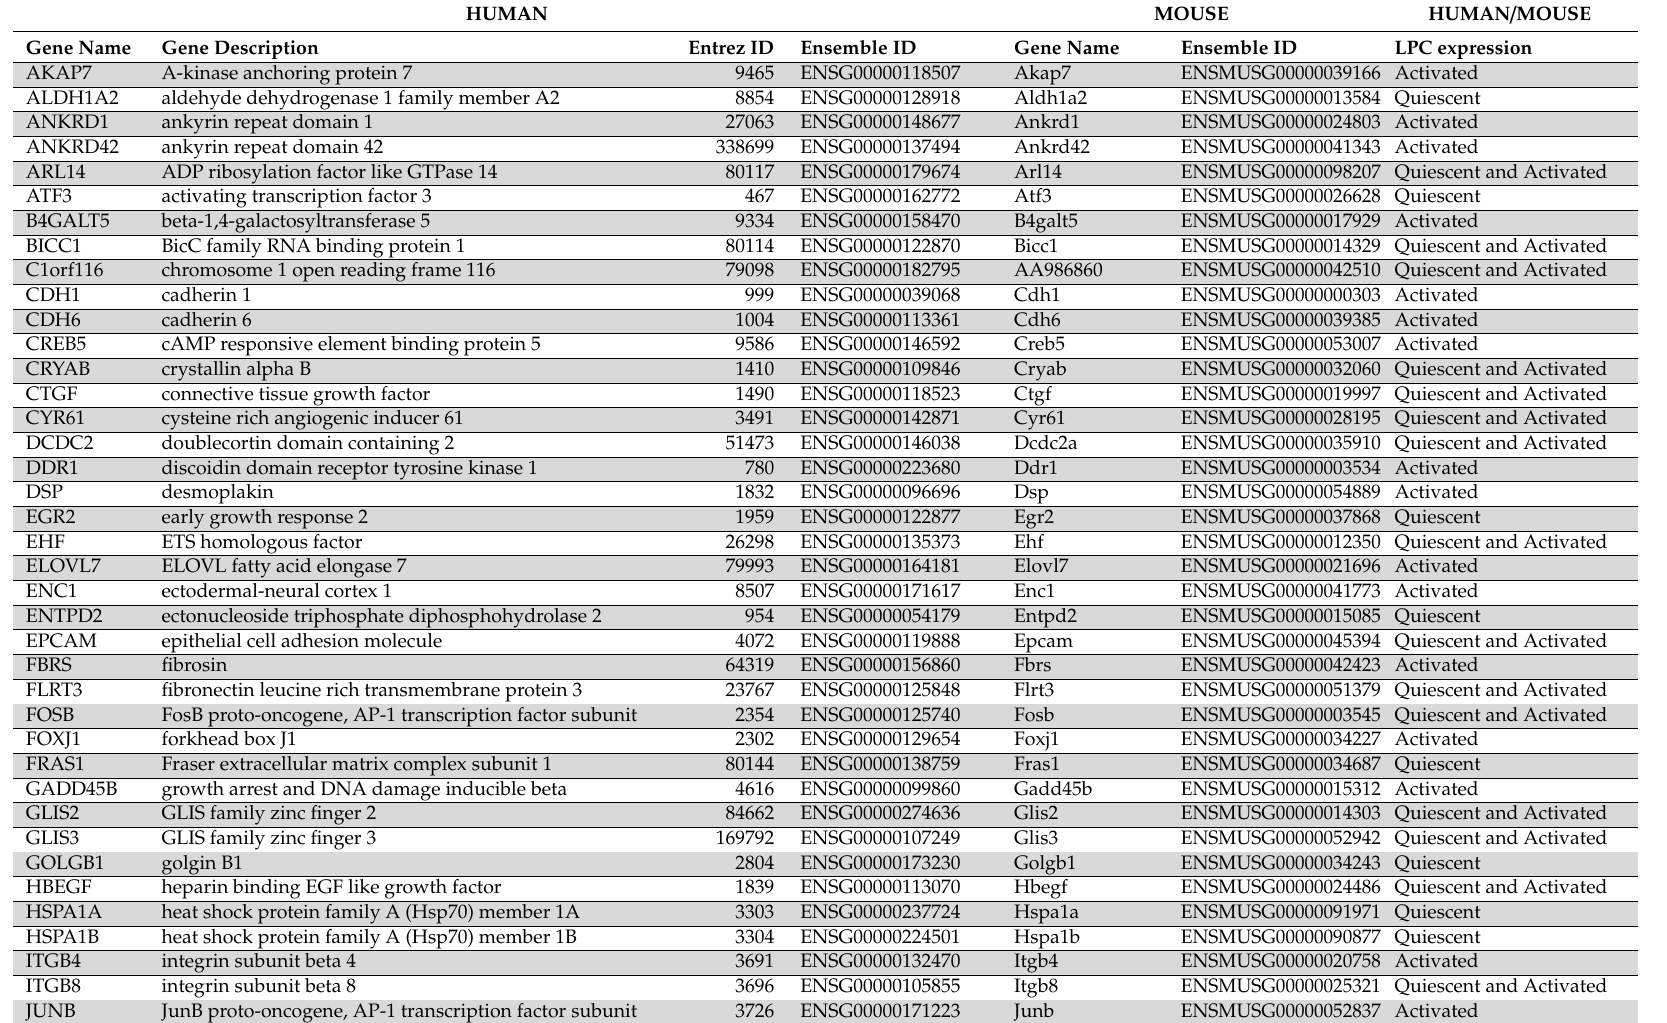
Table 3. List of human and mouse genes in quiescent and activated